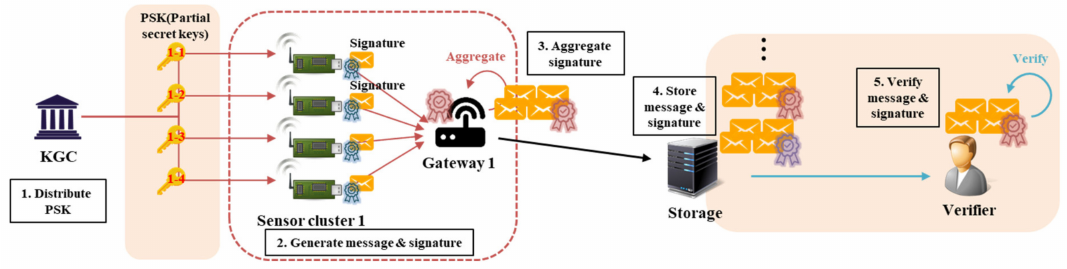
Figure2. Structureofthegeneralcertificatelessaggregatesignatureprocess.